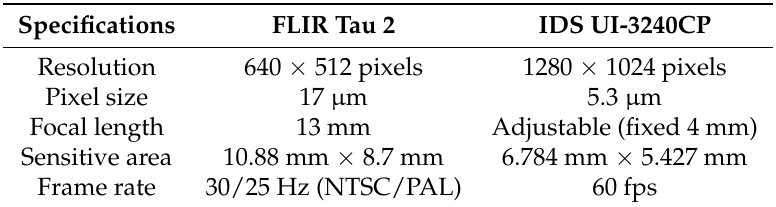
Table 1. Table 1. FLIR Tau 2 and UI-3240CP camera specifications.